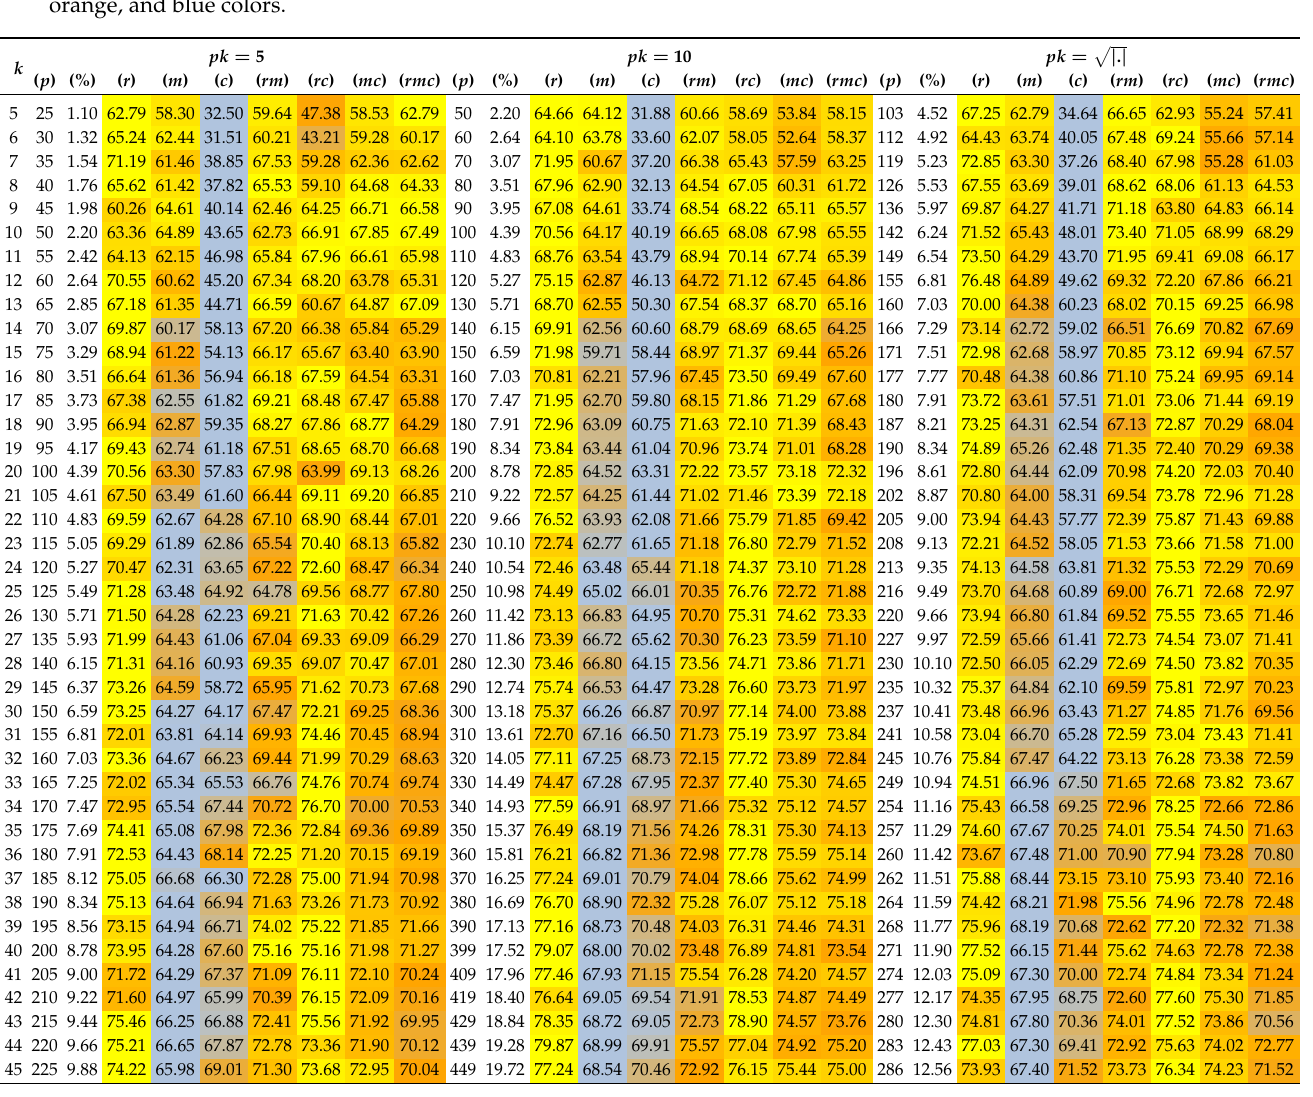
Table 1. Accuracy results (in percent 100%) of the labeling for the DS1 set with the best 30 features: each line represents a different number of clusters ( k ). In the columns from left to right, three groups of columns are indicated ( pk ), which refers (cid:112) | to the sample numbers per clustering (5, 10 e . | ). In each block of columns from left to right are indicated: (1) the total number of samples ( p ); (2) the percentage of samples (%) in relation to the total number of instances in the data set; and (3) the accuracy for each of the sampling strategies ( random ( r ), medoid ( m ), contour ( c )) and their combinations rm , rc , mc e rmc . In the heatmap, the yellow color represents the maximum accuracy values achieved (labels prediction), the blue color represents the minimum values, the intermediate accuracy values are visualized with a color gradient between the yellow, orange, and blue